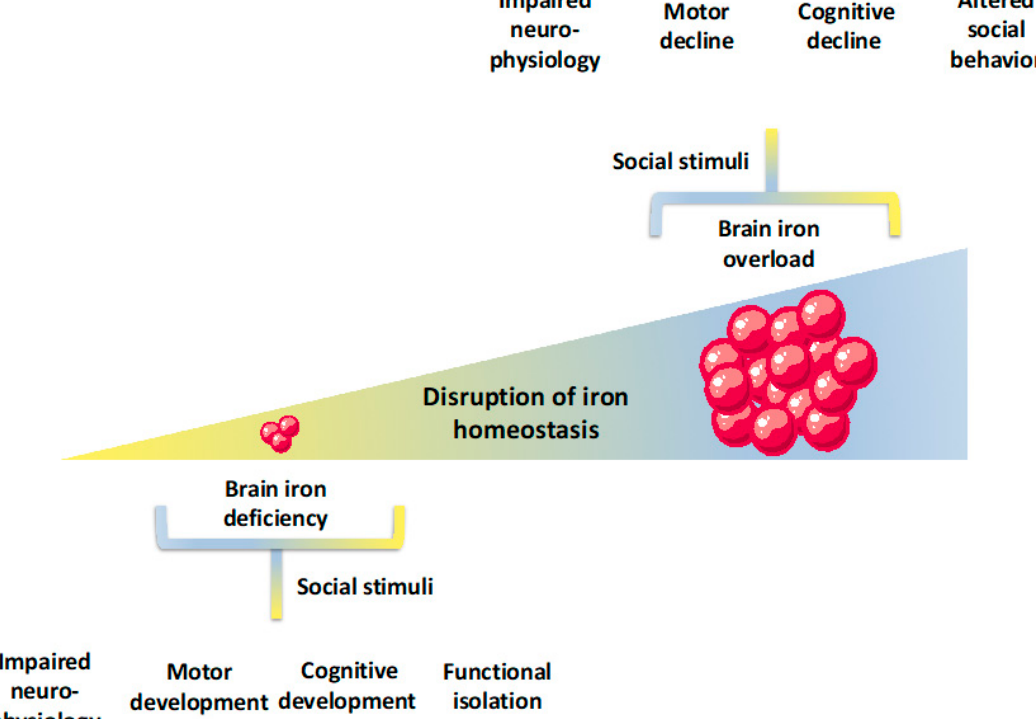
Figure 3. Multilevel repercussions of iron deficiency and iron overload in the brain. Brain iron deficiency is associated with disruption of neurophysiological mechanisms that, within a social context that does not provide regular stimuli, compromises motor and cognitive development (e.g.,